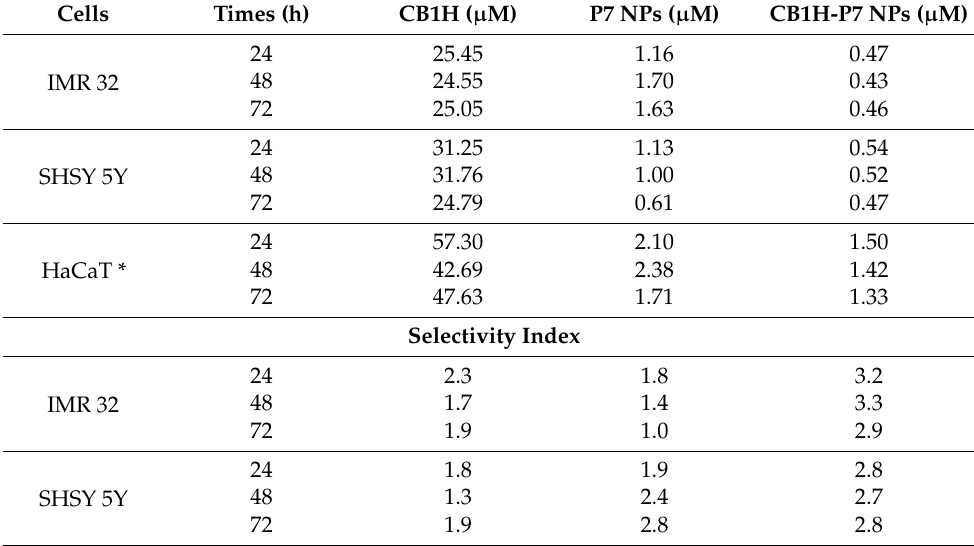
Table 2. IC 50 of CB1H, P7 and CB1H-P7 NPs towards IMR-32 and SHSY 5Y cells and normal human keratinocytes (HaCaT) at 24-, 48- and 72 h exposure, computed by experiments carried out in the range of concentrations 5–50 µ M (CB1H), 1–100 µ M (HaCaT) and 0.14–1.44 µ M (P7 and CB1H-P7). SI values were also reported. Cells Times (h) CB1H ( µ